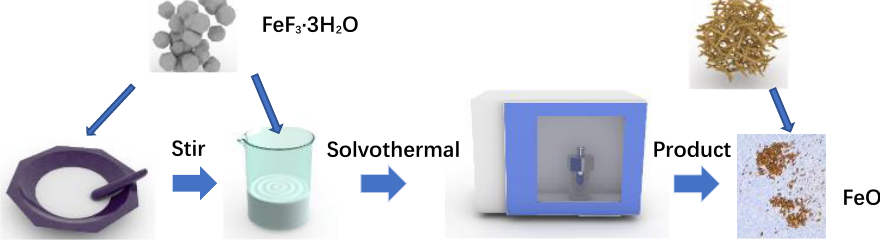
Figure 1. Schematic process of the formation of FeOF nanorods.